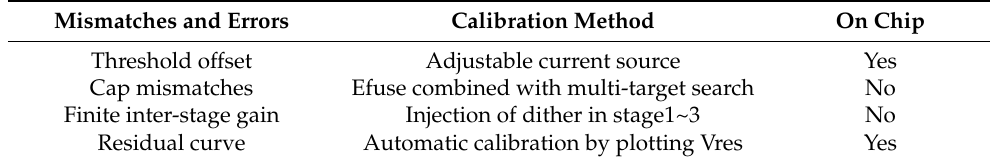
Table 1. Calibration strategies of this ADC. Mismatches and